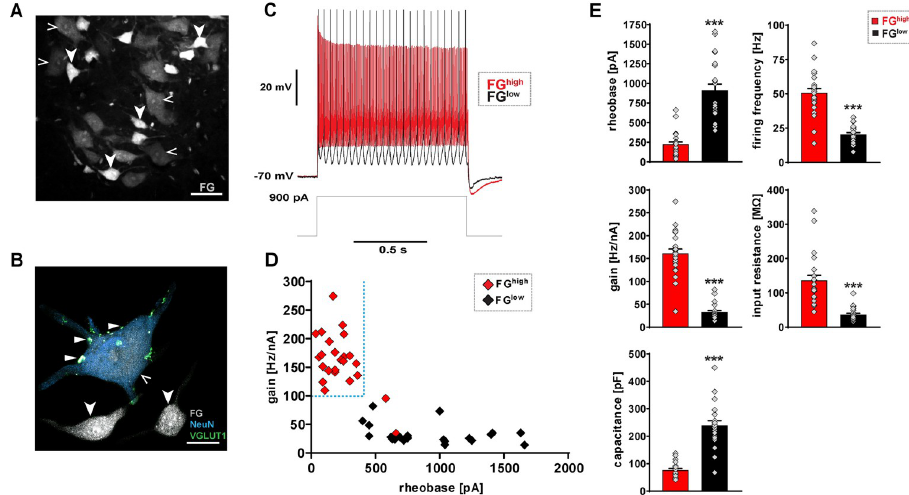
Fig 1. Direct electrophysiological interrogation of alpha and gamma motor neurons (A-D) . (A) Transversal section of P21 (wild-type) mouse lumbar spinal cord ventral horn: motor neurons labeled by retrograde tracer Fluoro- Gold (FG). Putative alpha motor neurons retain low levels of FG in soma (FG low ) (open arrowheads), while putative gamma motor neurons retain high levels of FG in soma (FG high ) (arrowheads) (scale bar: 50 μ m). (B) Imaris 3D reconstruction: VGLUT1 + synaptic varicosities (triangles) associated with FG low and NeuN high alpha motor neuron (open arrowheads), but not with adjacent FG high and NeuN low or negligible gamma motor neurons (arrowheads) (scale bar: 20 μ m). (C) Whole-cell patch-clamp recordings: example traces of FG high (black) and FG low (gray) motor neurons upon 900 pA, 1 second square current pulse. (D) Scatter plot: FG high ( n = 24, N = 16) and FG low ( n = 22, N = 12) motor neurons exhibit divergent gamma and alpha subtype-defining electrophysiological signatures, respectively, including gamma subtype-specific combination with low rheobase and high gain by FG high motor neurons (see S1 Table for details). (E) FG high motor neurons have significantly lower rheobase (pA) (221.87 ± 31.34), higher firing frequency (Hz) (50.65 ± 3.23), higher gain (Hz/nA) (161.01 ± 9.77), higher input resistance (136.62 ± 14.63), and lower capacitance (76.07 ± 6.01) when compared to FG low motor neuron rheobase (909.09 ± 82.11), firing frequency (20.41 ± 1.70), gain (32.64 ± 4.02), input resistance (36.55 ± 4.16), and capacitance (239.1 ± 17.17), respectively (see S1 Table for details). Data are presented as mean ± SEM. n = # of neurons, N = # of mice. Statistically significant differences between FG high and FG low neurons are indicated as ��� p < 0.001, Student t test). Data for Fig 1D and 1E can be found in S1